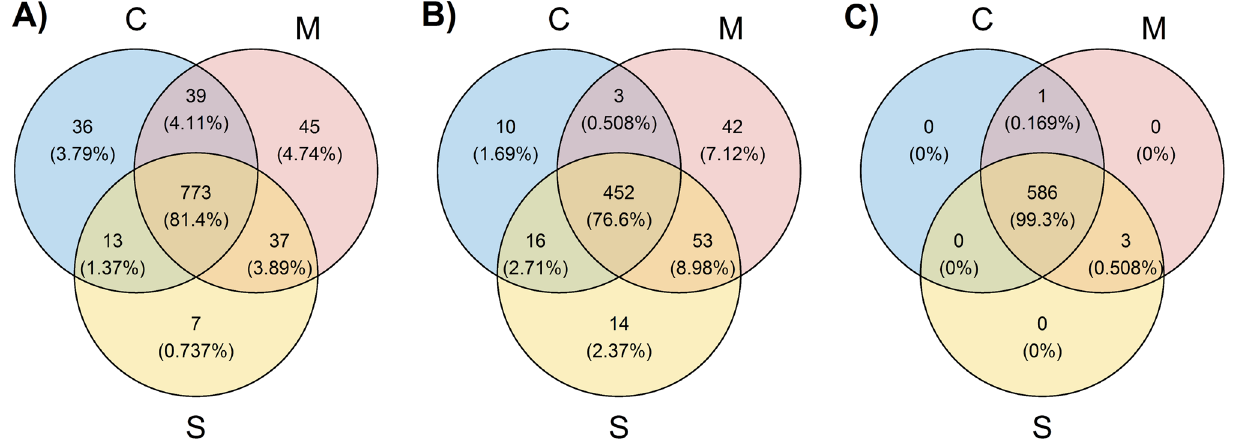
Figure 1. Proteins identified in selected groups. ( A ) All (950 in total) proteins identified; ( B ) proteins identified in at least 50% of samples in the given group (590); ( C ) proteins identified in at least 50% of the samples in at least one group of M, S, or C